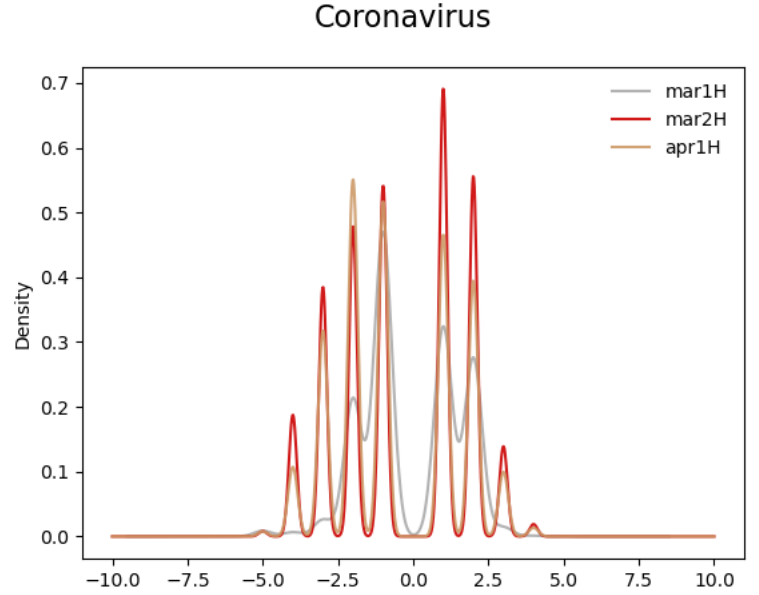
Figure 3. Sentiment score distribution of contextual words of “Coronavirus”.